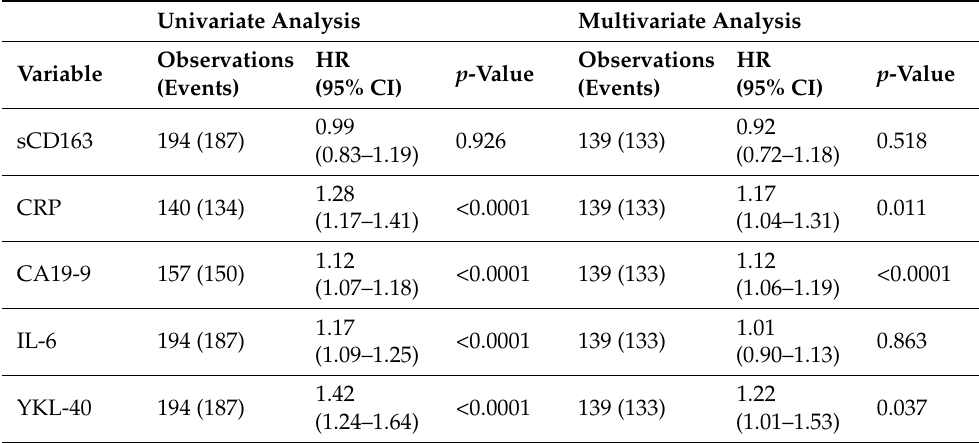
Table 4. Univariate Cox regression analyses for OS according to sCD163, CRP, CA19-9, IL-6 and YKL-40 concentrations (log-transformed), PS, age, and sex, for patients with stage 3 + 4 pancreatic ductal adenocarcinoma. #,